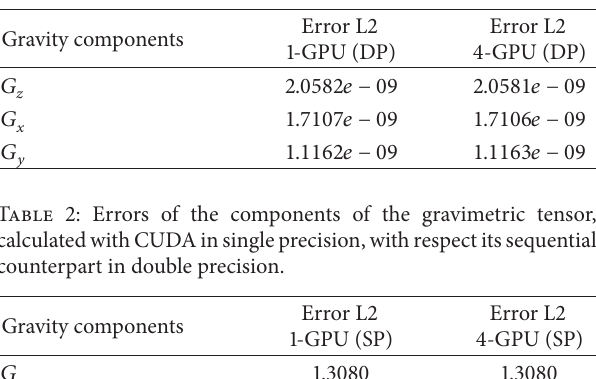
Table 1: Errors of the components of the gravimetric tensor, calculated with CUDA in double precision, with respect to its sequential counterpart in double precision.